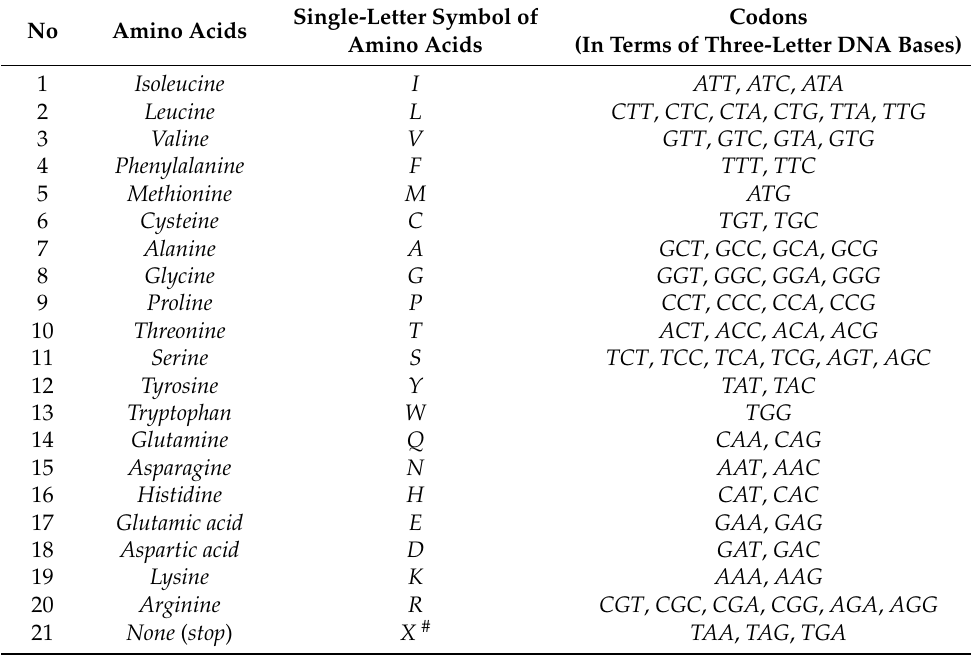
Figure 6. Schematic illustration of DNA-based computing (DBC). Table 2. Genetic codes [32].